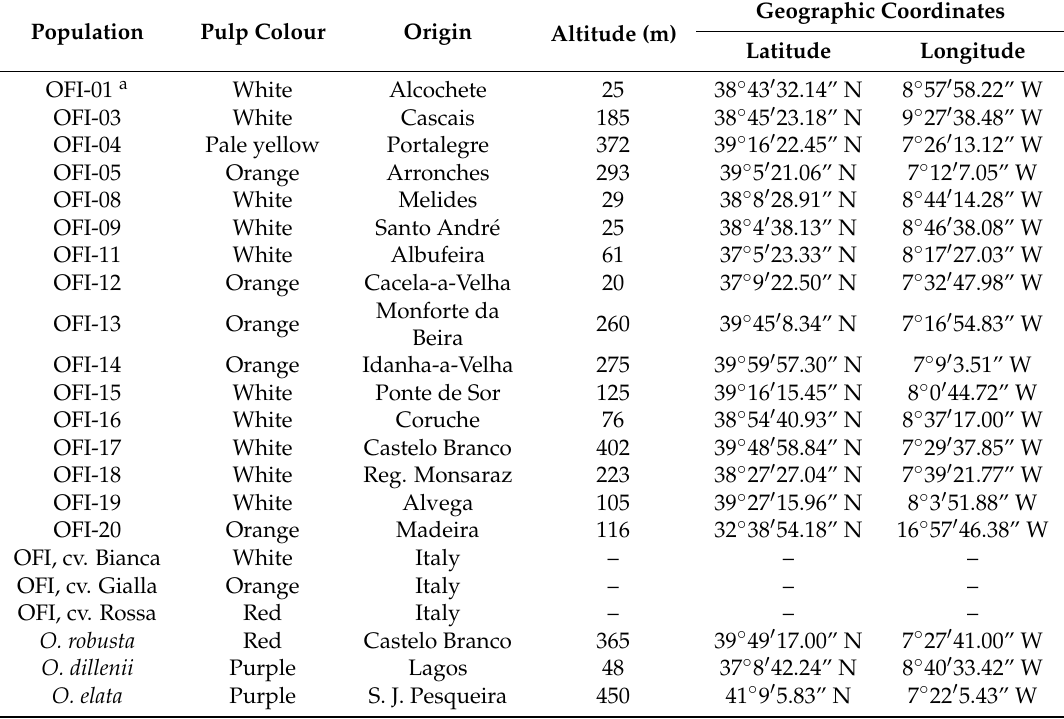
Table 1. Identification, pulp colour and origin of the studied Opuntia spp.